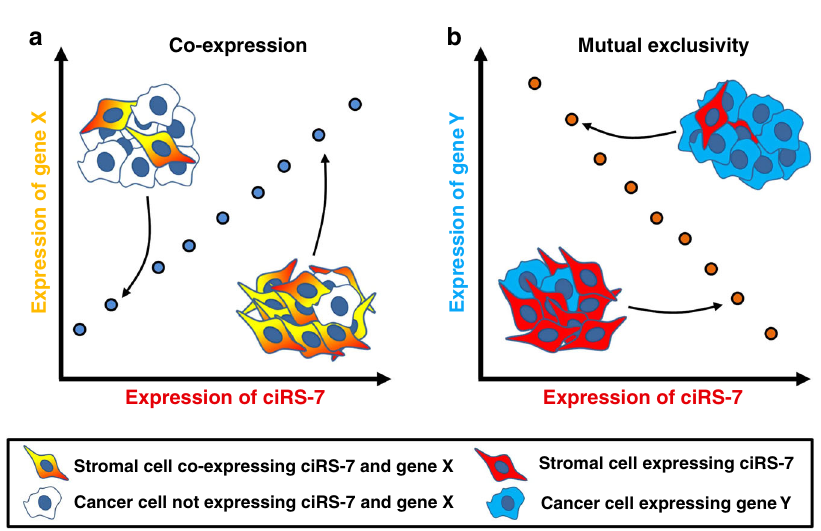
Fig. 3 A simple model explains correlations between ciRS-7 and miR-7 target genes. a When ciRS-7 is co-expressed with gene X in the stromal cells, positive correlations will be observed as samples with relatively higher amounts of stromal cells relative to cancer cells will have a relatively higher expression of ciRS-7 and the gene X. b When ciRS-7 and gene Y are mutually exclusively expressed in the stromal and cancer cells, negative correlations will be observed as samples with relatively higher amounts of stromal cells relative to cancer cells will have a relatively higher expression of ciRS-7, whereas as samples with relatively higher amounts of cancer cells relative to stromal cells will have a relatively higher expression of the gene Y. Additional cell types with other expression patterns are likely to confound the analyses when analyzing tumor specimens, leading to poorer correlations than illustrated